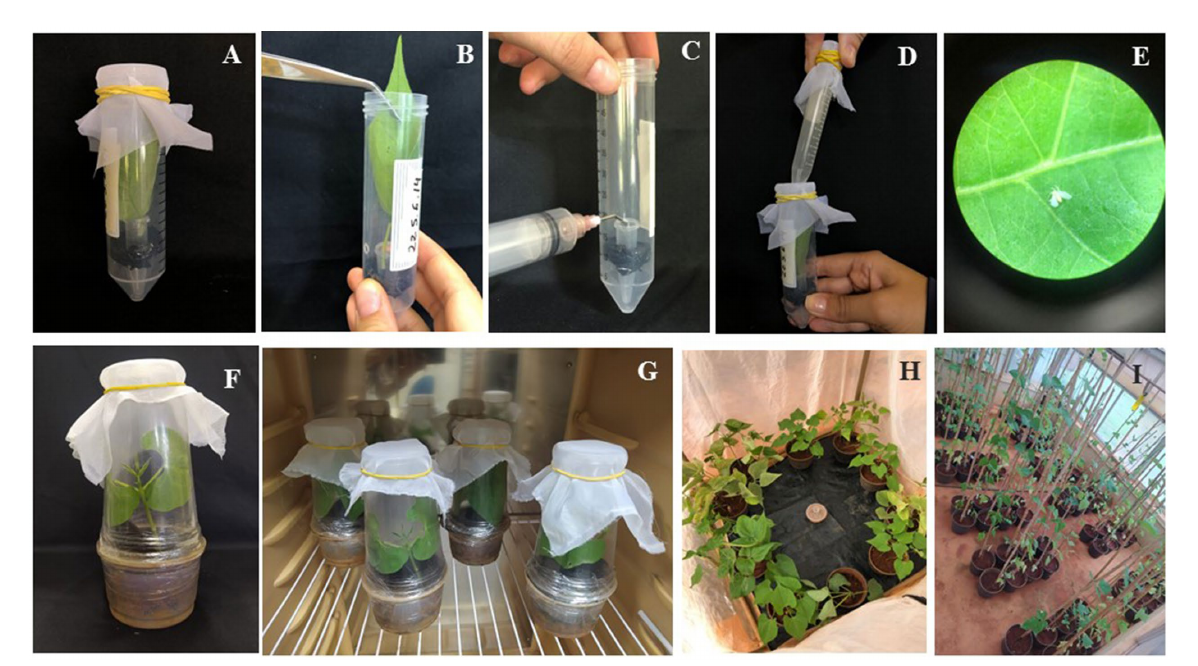
FIGURE 1 Whitefly mortality and preference assays. (A) Bioassay system developed to conduct the insect mortality assays with detached leaves of the transgenic common bean lines, with voile fabric covering the upper part of the tube; (B) Plant leaf being inserted into the bioassay system; (C) Microtube used to place water and maintain the leaf for the period of the evaluations; (D) Release of adult insects inside the Falcon tube; (E) Close-up photo of dead insect on GM bean leaf; (F) Plastic cup cage to isolate the plants; (G) Plants in the growth chamber for the whole-plant experiment; (H) Transgenic and non-transgenic common bean plants randomly distributed in a circle under a large voile cage, where insects were released in the center, for the preference assays and (I) Transgenic and non-transgenic common bean plants distributed in blocks in the greenhouse for the experiment during the common bean